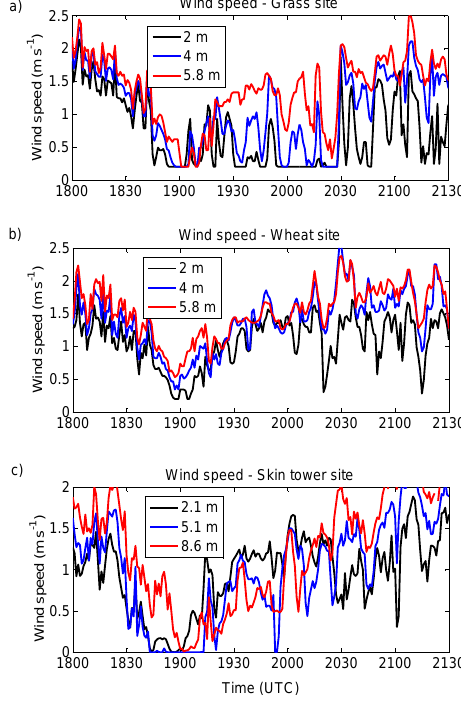
Figure 4. Wind speed (ms − 1 ) measured at different heights at the grass site (a) , wheat site (b) and skin-tower site (micro area) (c)